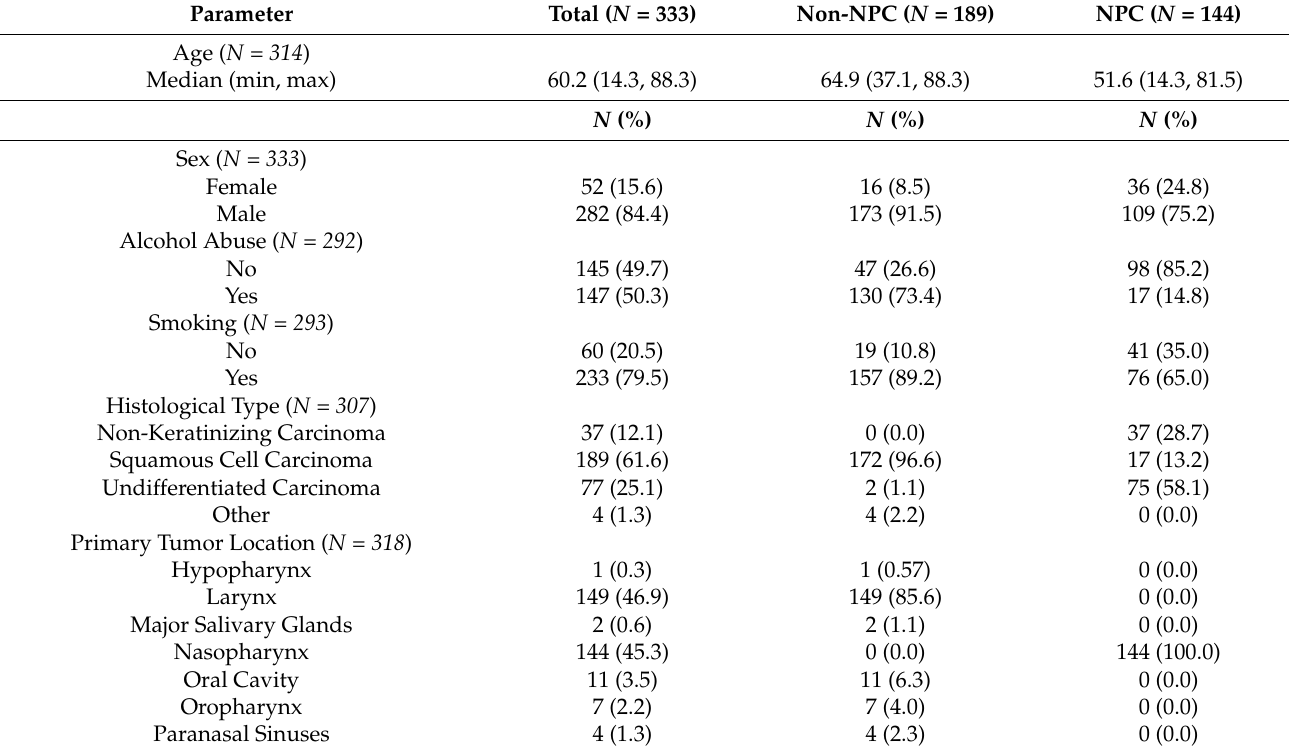
Table 1. Patient and tumor characteristics by tumor